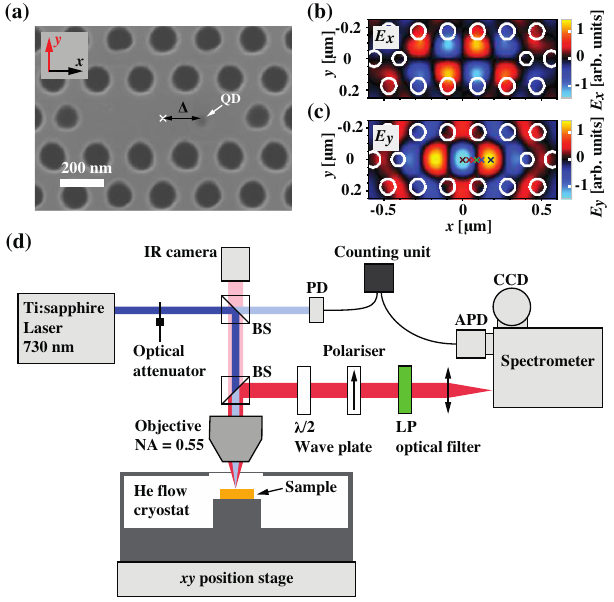
FIG. 1. (a) SEM image of a fabricated structure showing the displacement Δ of the QD from the cavity center. (b),(c) Simulated E and E electric fields of the fundamental cavity mode at a half- x y membrane height and 1.42 meV energy. Crosses in (c) show the implemented Δ providing different exciton-CM coupling strengths g ð Δ Þ . The CM near-field patterns in (b) and (c) were calculated using a 2D FDTD method. (d) Schematics of the μ PL optical setup. The laser beam used for excitation is highlighted in blue whereas collected photoluminescence is highlighted in red. BS in (d) stands for a nonpolarizing beam